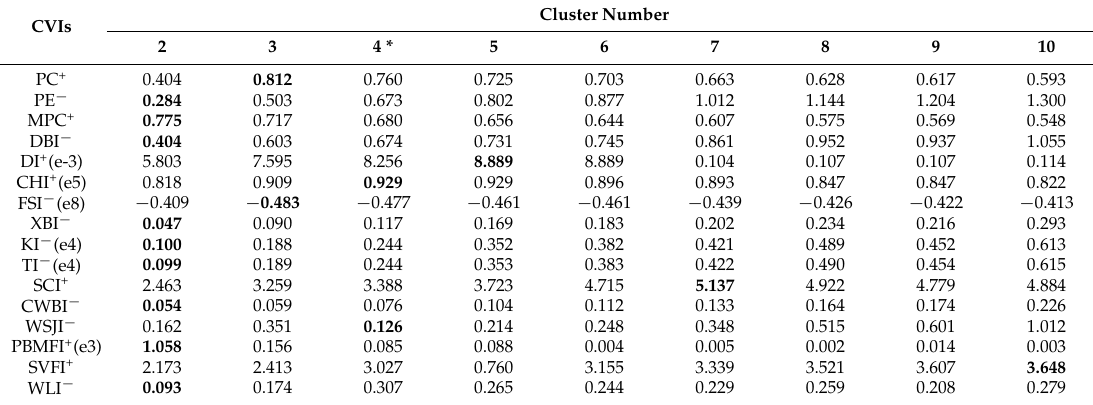
Table 5. Variations of the 16 CVIs with cluster numbers ranging from 2 to 10 for the ETM+ image.